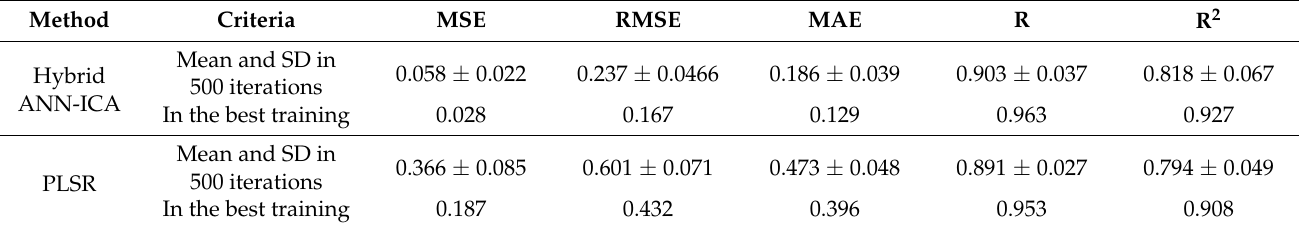
Table 3. Comparison of various criteria evaluating the efficiency of ANN-ICA and PLSR for predicting TSS in 500 replications using spectral data of key wavelengths.